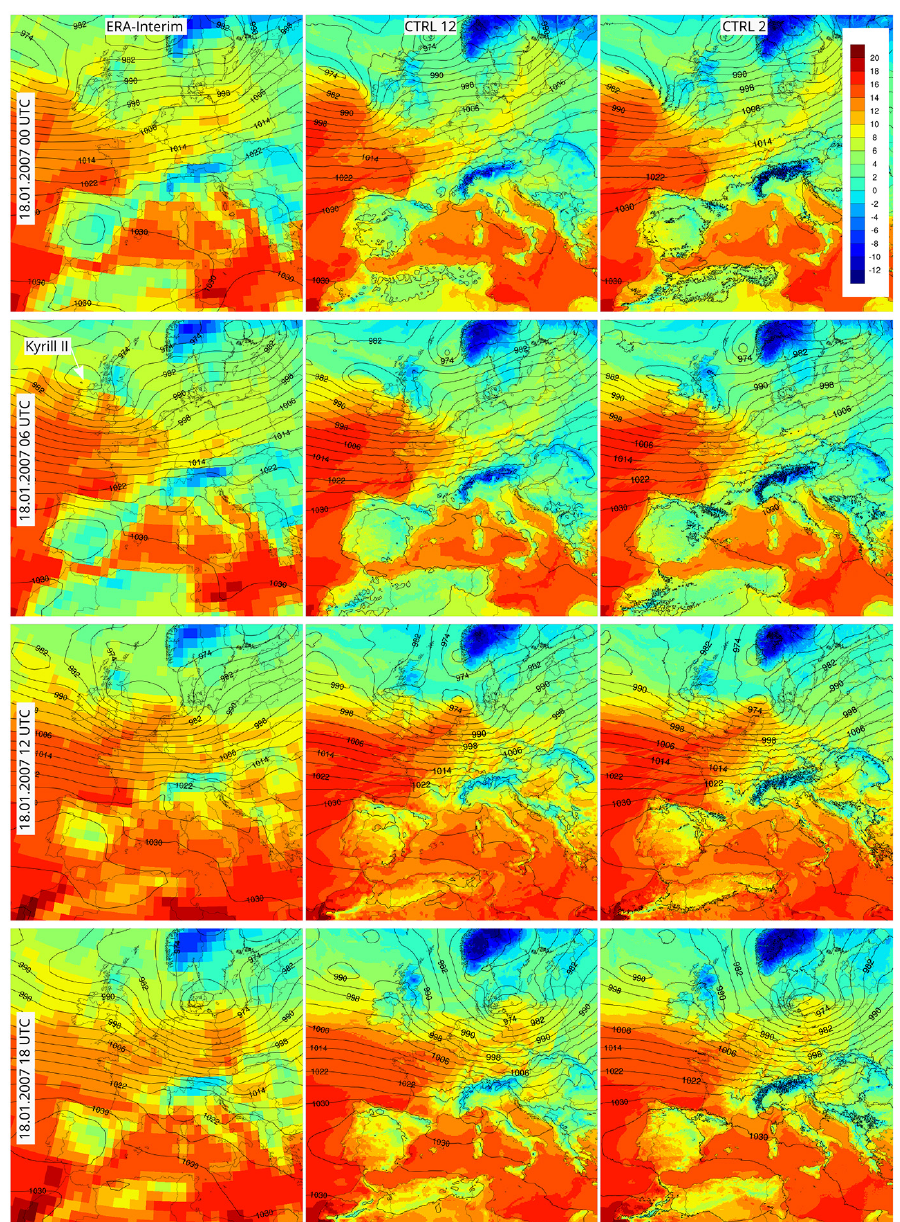
Figure 3. Snapshots of the Kyrill II winter storm in ERA-Interim (left column), CTRL12 (middle column) and CTRL2 (right column) in their native resolution. The shading denotes raw 2m temperature [ ◦ C] and the black contours mean sea-level pressure [hPa]. The contour-level spacing is